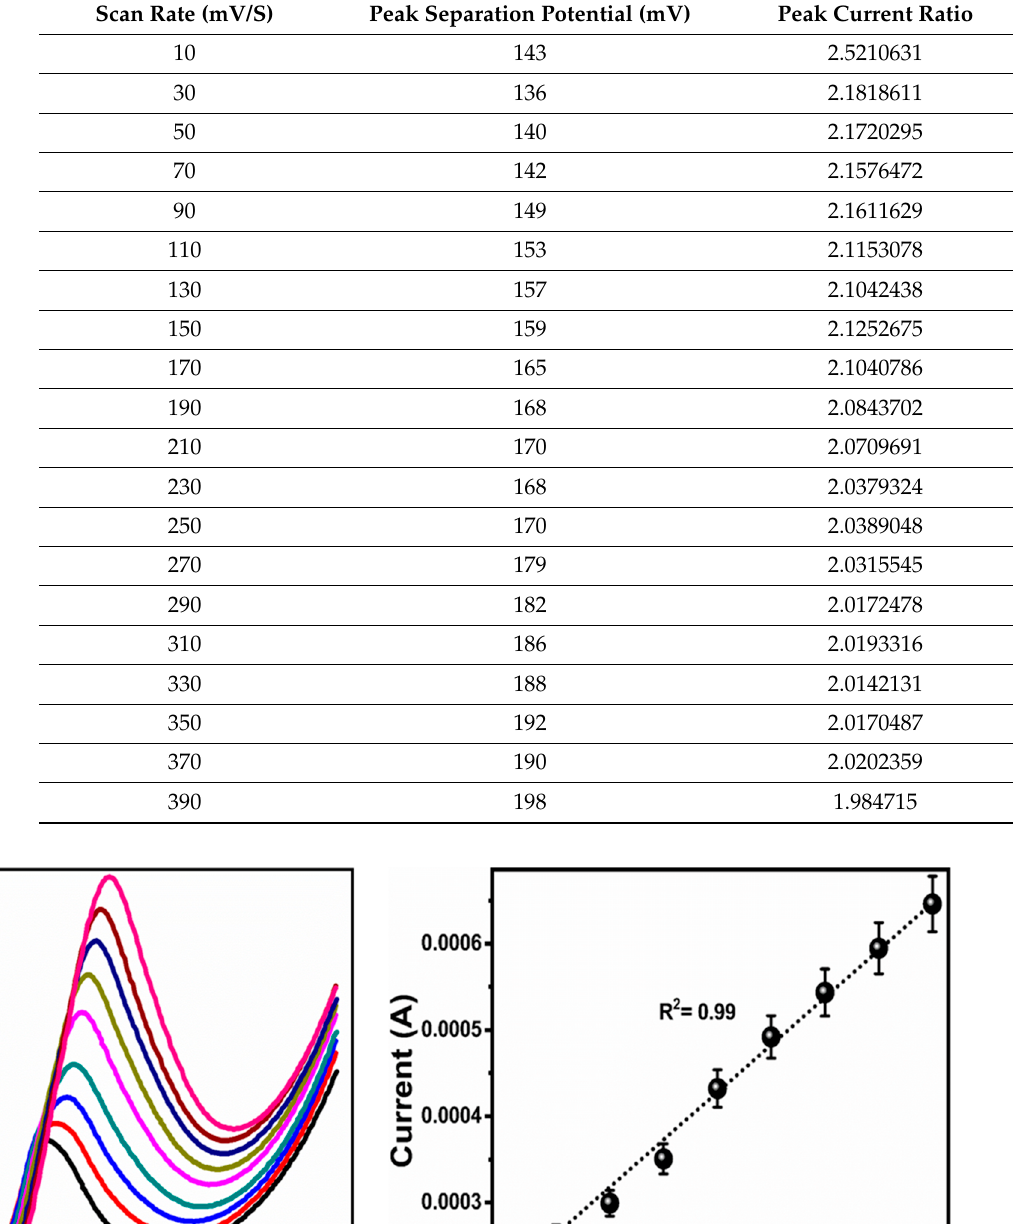
Table 1. The estimated separation potential and peak current ratio at different scan rates. Scan Rate (mV/S) Peak Separation Potential (mV)